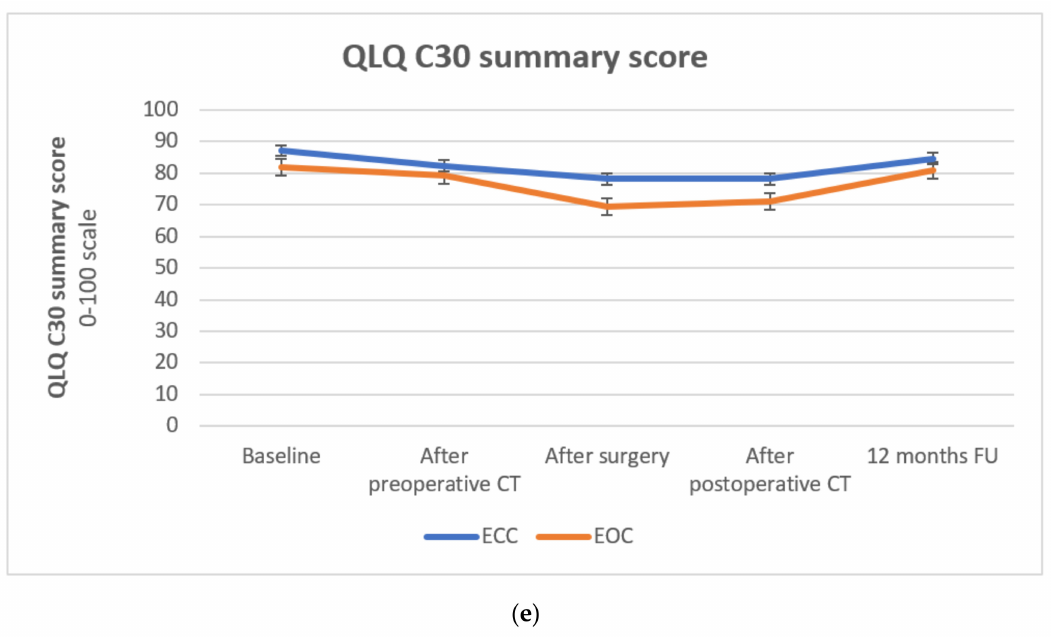
Figure 3. HRQOL scores at baseline, after preoperative chemotherapy, after surgery, after postoper- ative chemotherapy, and at 12-month follow-up (from randomization). ( a ) Cognitive functioning. A higher score means better cognitive functioning. Interaction between time and group (ECX ver- sus EOX): p = 0.629, ( b ) Physical functioning. A higher score means better physical functioning. Interaction between time and group (ECX versus EOX): p = 0.801, ( c ) Nausea/vomiting. A higher score means more symptoms of nausea/vomiting. Interaction between time and group (ECX versus EOX): p = 0.950, ( d ) Diarrhea. A higher score means more symptoms of diarrhea. Interaction between time and group (ECX versus EOX): p = 0.544, ( e ) QLQ C30 summary score. A higher score means a better overall score. Interaction between time and group (ECX versus EOX): p =